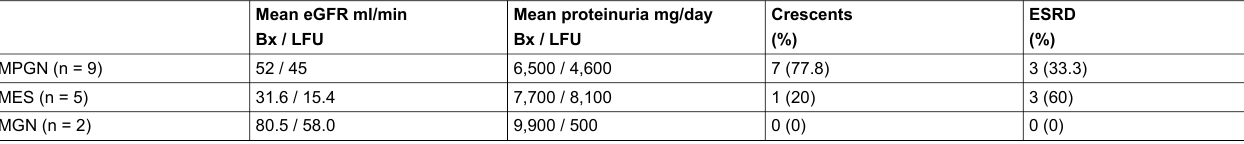
Table 3: Outcome with regard to the observed type of glomerulonephritis: at time of biopsy (Bx) / last follow up (LFU).